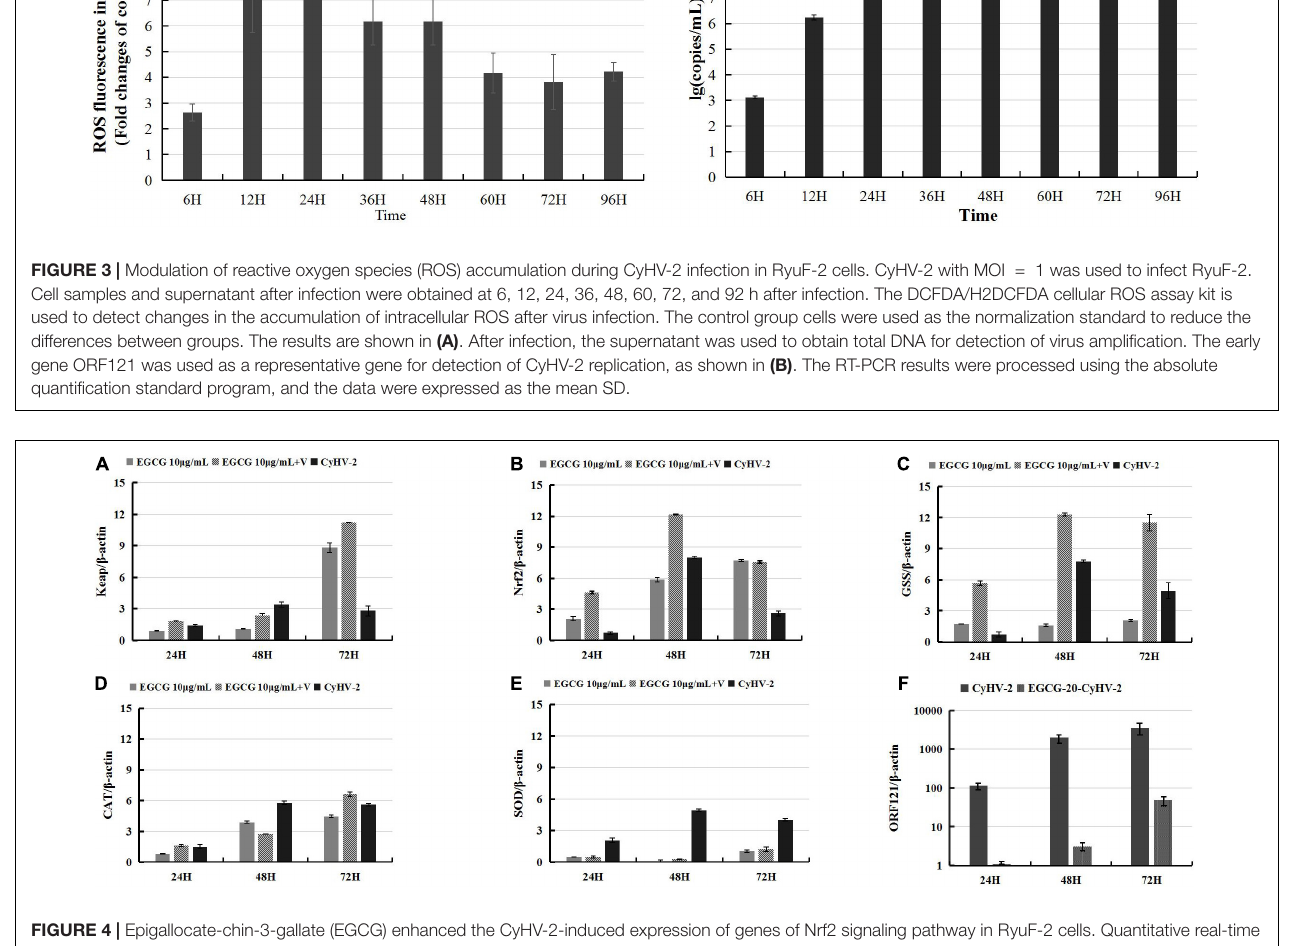
FIGURE 4 | Epigallocate-chin-3-gallate (EGCG) enhanced the CyHV-2-induced expression of genes of Nrf2 signaling pathway in RyuF-2 cells. Quantitative real-time RT-PCR analysis was performed to compare the transcriptional expression levels of Keap1 (A) , Nrf2 (B) , GSS (C) , CAT (D) , SOD2 (E) and viral ORF121 (F) in infected cells. The mRNA level was normalized against housekeeping gene β -actin. MOCK-infected cells treated with 10 µ g/ml EGCG and CyhV-2-infected cells without EGCG treatment served as controls. Similar results were obtained from three independent experiments. Data were represented as means